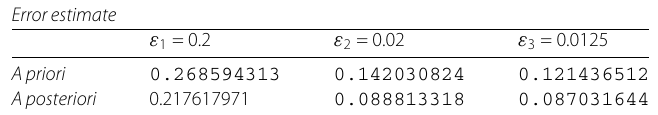
Table 1 The error between the regularized solutions and sought solution at β = 0.5, γ = 0.5